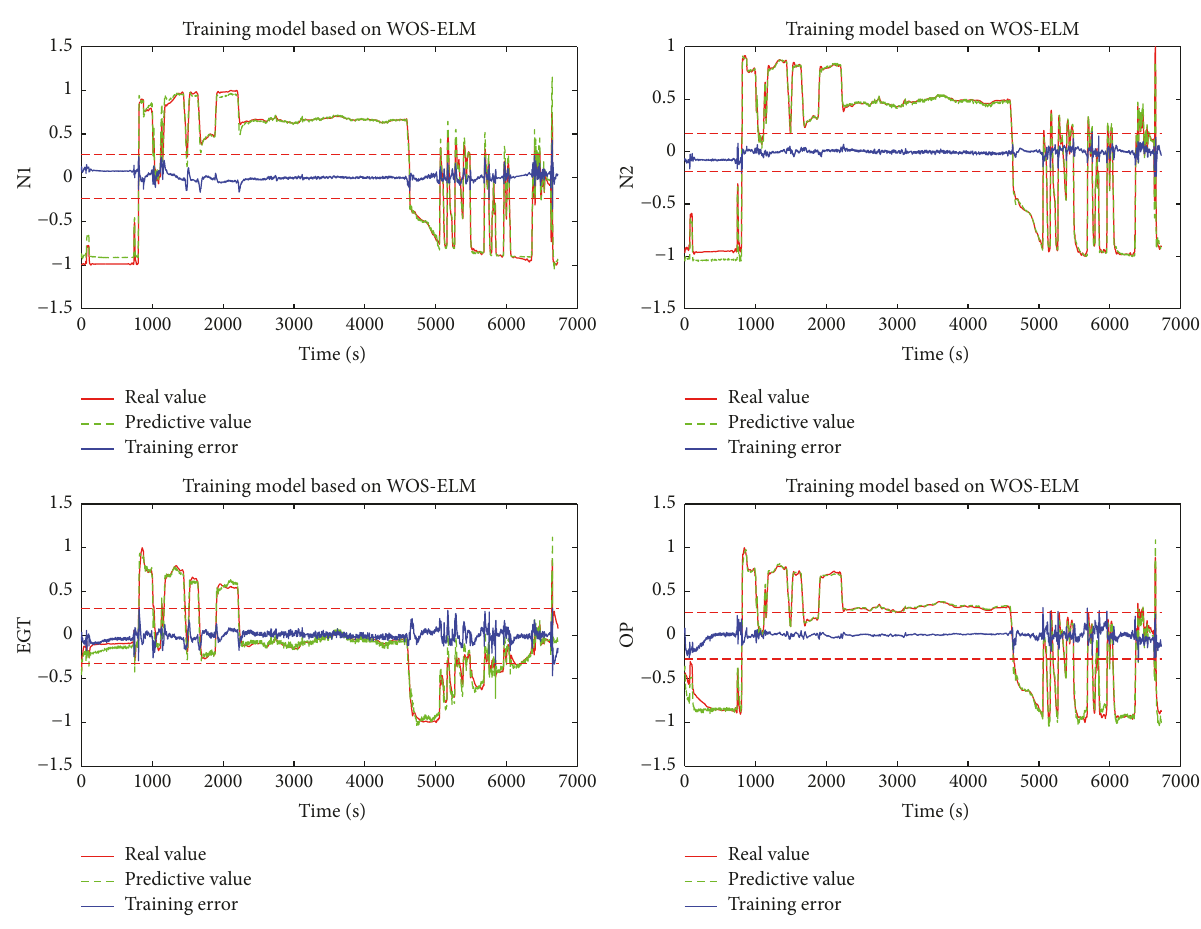
Figure 4: Training results for sensors under normal